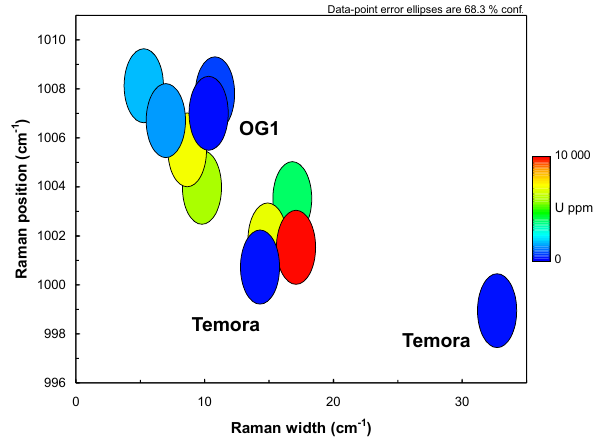
Figure 7. Raman peak position vs. peak width at half height for Raumid zircons and reference zircons OG1 and